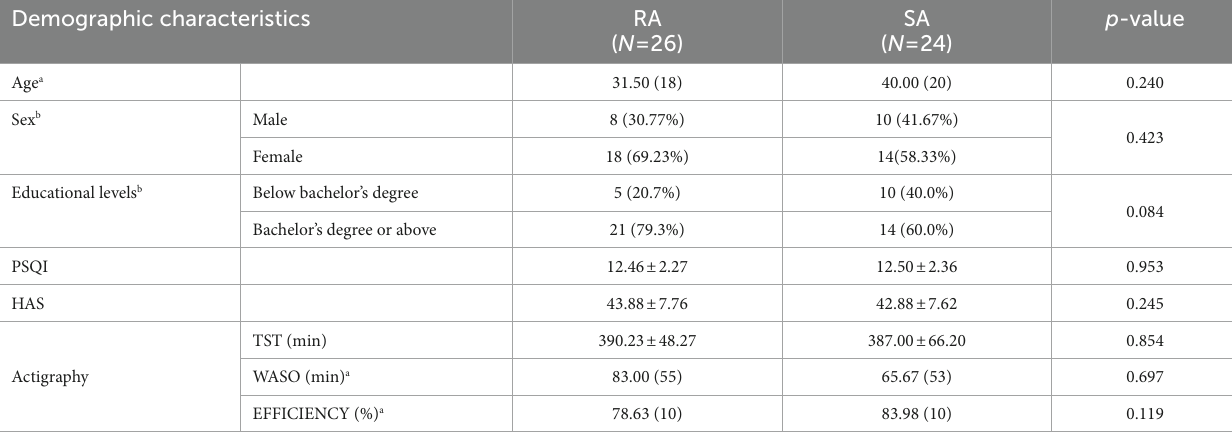
TABLE 1 Demographic and clinical characteristics of ID patients. Demographic